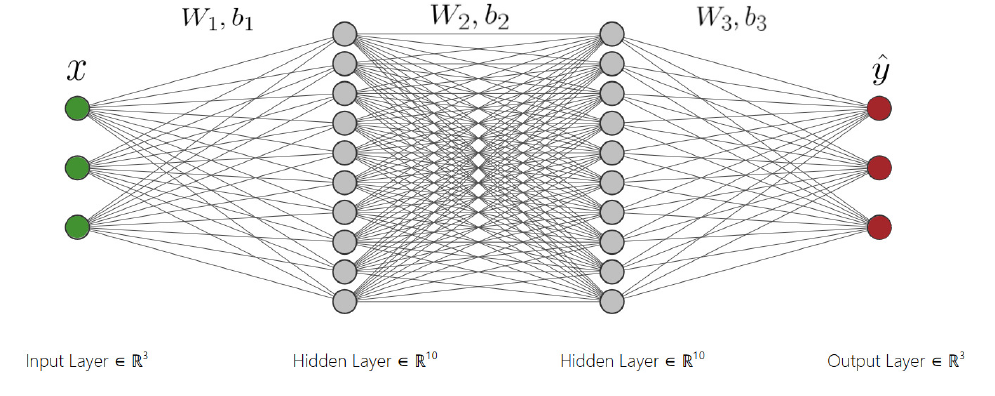
Figure 3. A fully-connected feed-forward neural network. The input layer x has three features, each of the two hidden layers has 10 neurons and the output layer (cid:98) y has three